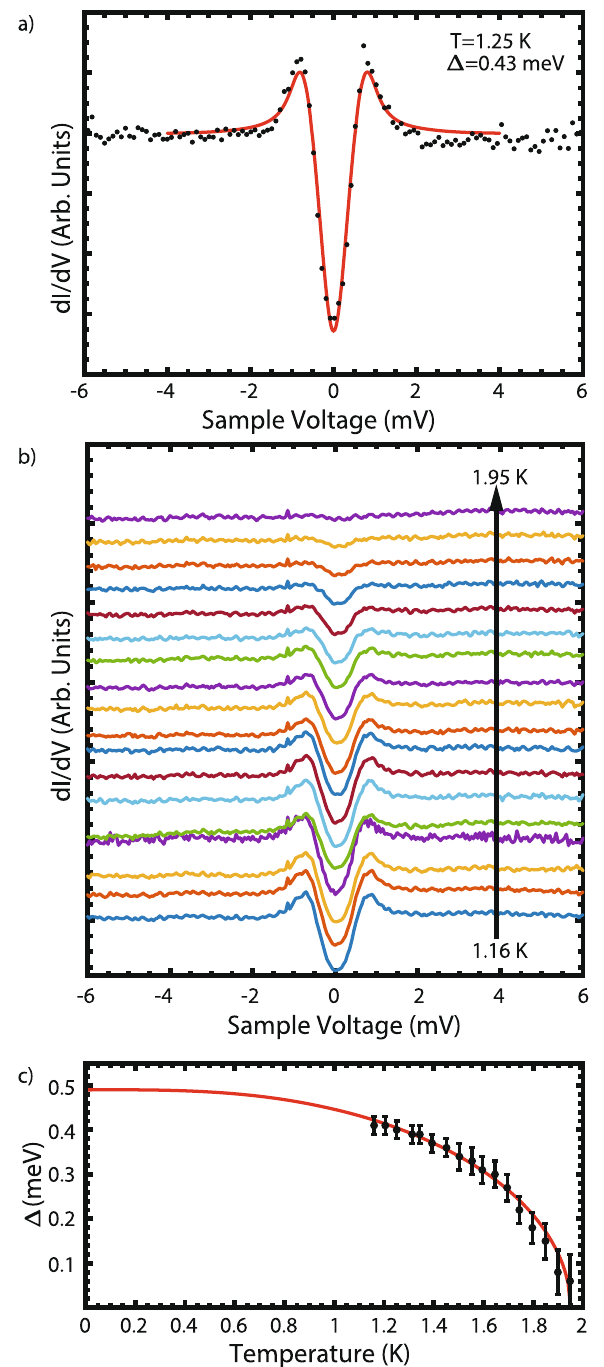
Fig. 3 Characterization of the superconducting gap by STS. a Representative d I /d V differential conductance spectrum of the 1T-PdTe 2 surface at 1.25 K, showing the characteristic superconduct- ing gap in the absence of external magnetic fi eld (black dots). b Normalized d I /d V spectra with varying temperatures from 1.16 to 1.95 K. c Evolution of the superconducting energy gap ( Δ ) with the temperature (black dots). The red lines in ( a ) and ( c ) represent the fi t to the equation for a medium-coupling BCS superconductor 30 . A smaller experimental value indicates that the effective mean- square displacement of the surface-charge density, as given by HAS, is less than the one expected when the electrons move together with the atoms, as in the classical two-body collision